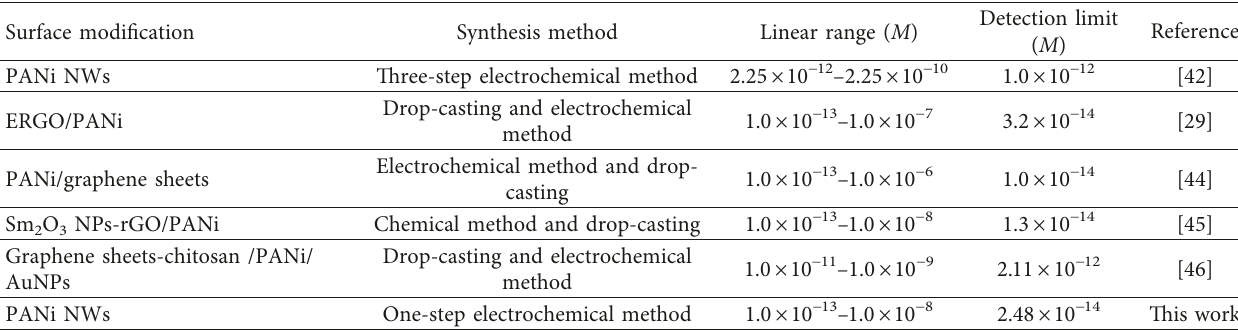
M, (c) 1.0 10 M, (d) 1.0 10 M, (e) 1.0 10 M, (f) 1.0 10 M, and (g) 1.0 10 M, respectively. 10 × × × × × × − 13 − 12 − 11 − 10 − 9 − 8 5mV, and E DC 160 mV; and (b) response of the DNA sensors to (a) different con- (cid:29) (cid:29) 10 − 8 M of noncomplementary target DNA. × Table 2: Comparison of this fabricated DNA sensor with some others in the literature.